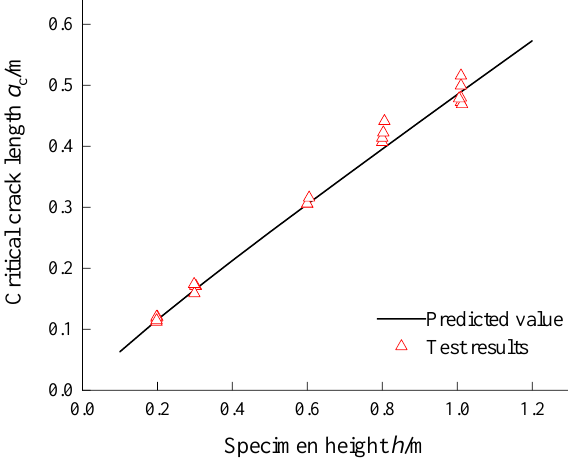
Figure 9. Critical crack length of specimens of different sizes.